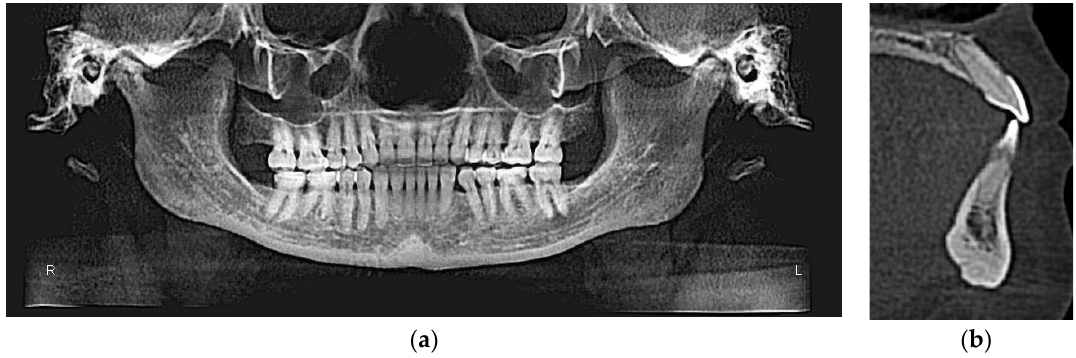
Figure 10. ( a ) Final CBCT-driven panoramic radiograph showing complete retraction of lower left canine; ( b ) final CBCT-driven sagittal screen showing bone formation labial to lower incisors compared to initial one with severely proclined lower incisor.